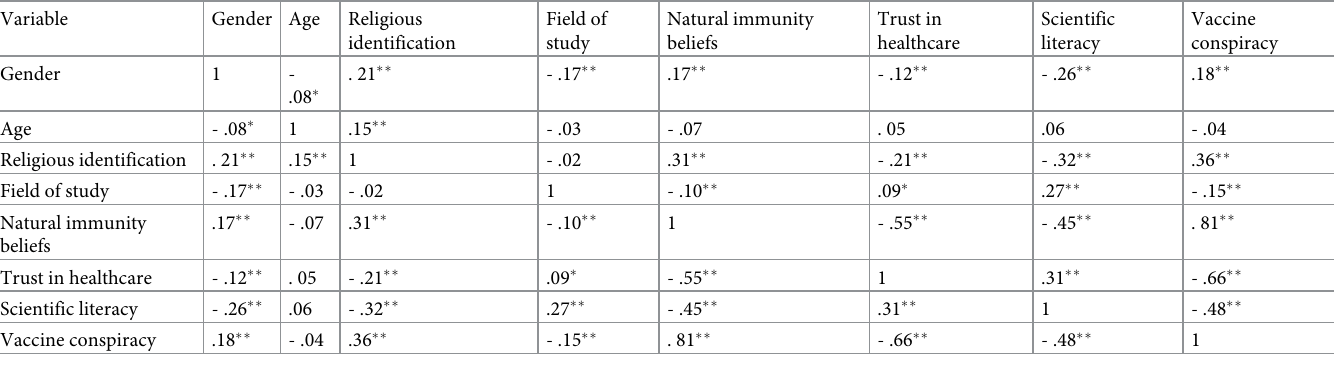
Table 5. Intercorrelation matrix (Pearson’s